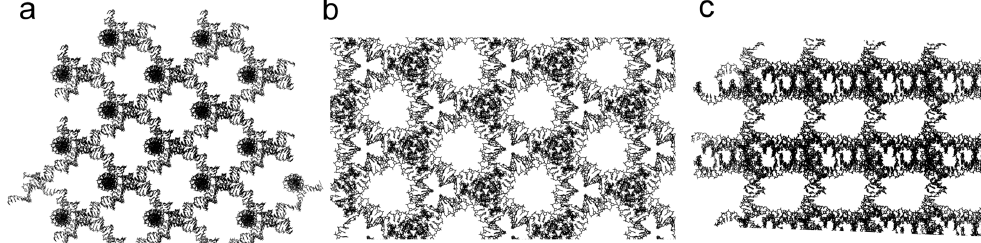
Figure 4. Solvent channels. The tensegrity triangle crystals form multiple solvent channels that run through the crystal in multiple directions. ( a ) Solvent channels that run along each helical axis of the motif. ( b ) and ( c ) Two other channels that run through the crystal.